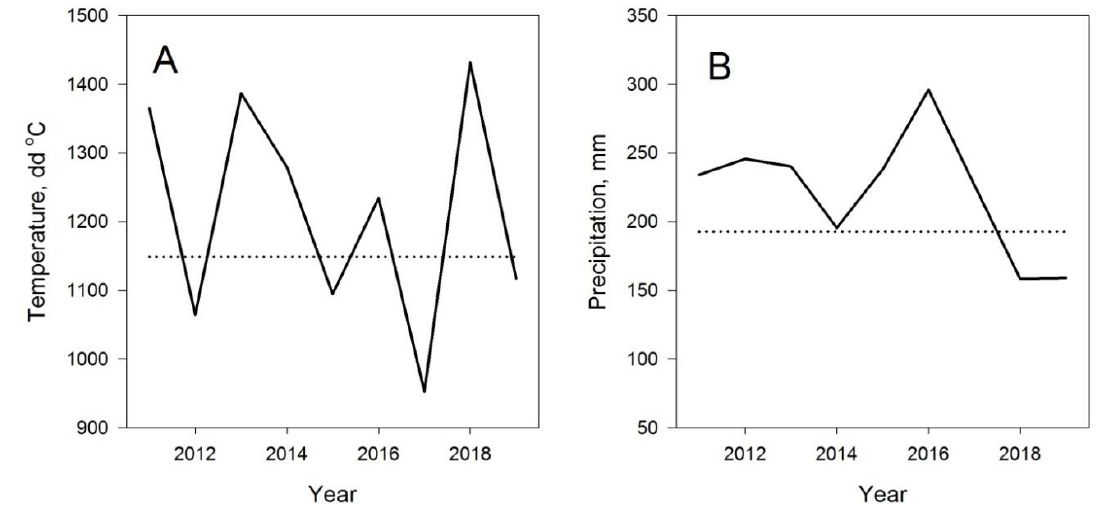
Figure 1. Annual temperature sum ( A ), (dd threshold value 5 °C) and precipitation ( B ) in June to August 2011–2019. Dotted lines show a 30-year average.